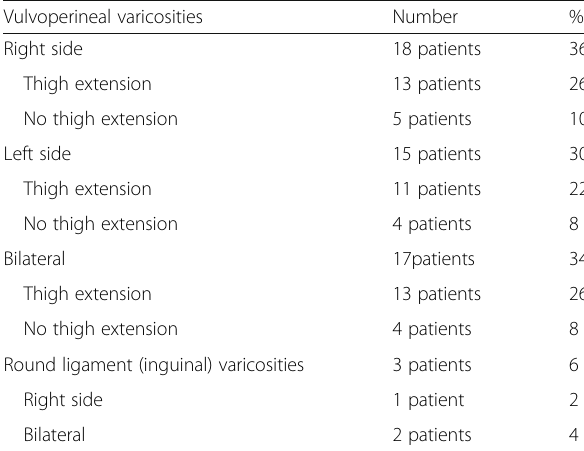
Table 4 Demonstrating the presence of the vulvoperineal varicosities, side of affection, thigh extension and the number and percent of the affected cases as well as the round ligament (inguinal) varicosities Vulvoperineal